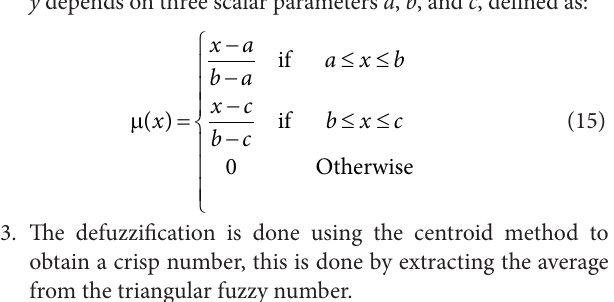
TaBle 1 | Matrix of inference rules used with the proposed fuzzy inference system. input speed regular Maximum Input distance Short Good Excellent Excellent Mean